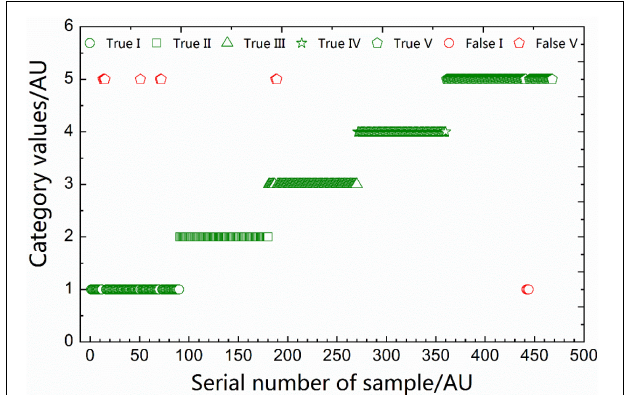
FIGURE 6 | Identification for the spectra of the validation samples based on the optimal equidistant combination (EC)-wavelength step-by-step phase-out (WSP)-Bayes